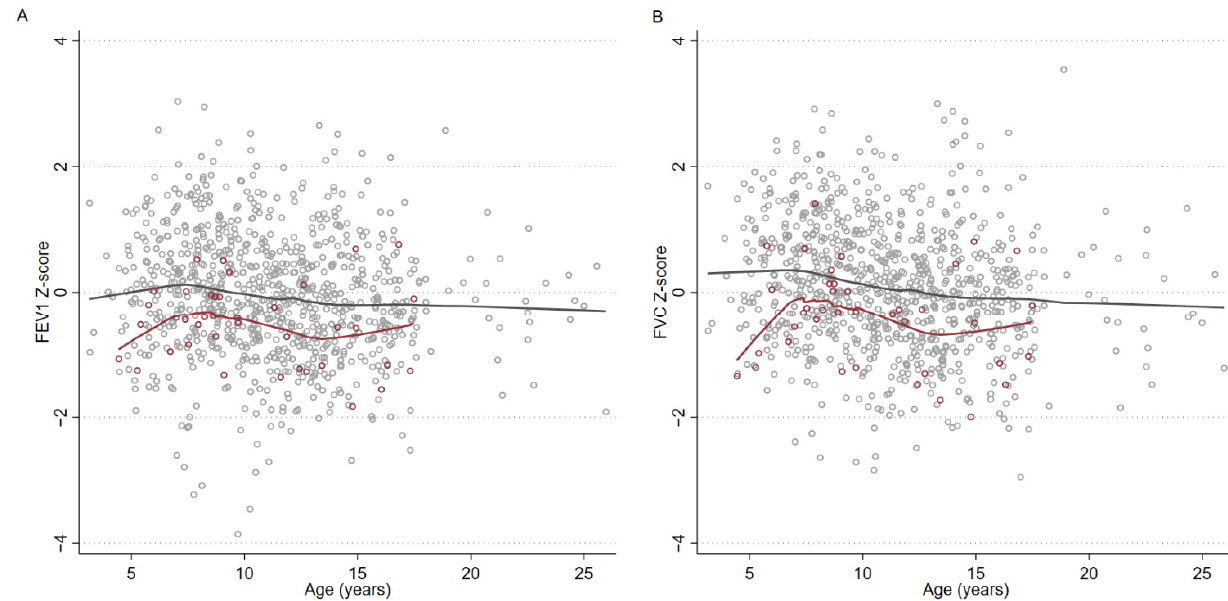
Figure 1. Scatter plots with lowess smoothing comparing FEV 1 ( A ) and FVC ( B ) Z-scores of First Nations subjects whose pneumonia occurred age ≤ 5 years versus other subjects. Locally weighted smoothing of participants shows the reduction in lung function occurring post early childhood pneumonia. Gray hollow circles mark participants with no history of pneumonia, or pneumonia occurring after age five years. Gray line is locally weighted smoothing of participants marked with gray hollow circles. Maroon hollow circles mark participants with a history of pneumonia occurring at or before age five years. Maroon line is locally weighted smoothing of participants marked with maroon hollow circles. Age as marked on the horizontal axis indicates the age of the participant when lung function was performed.